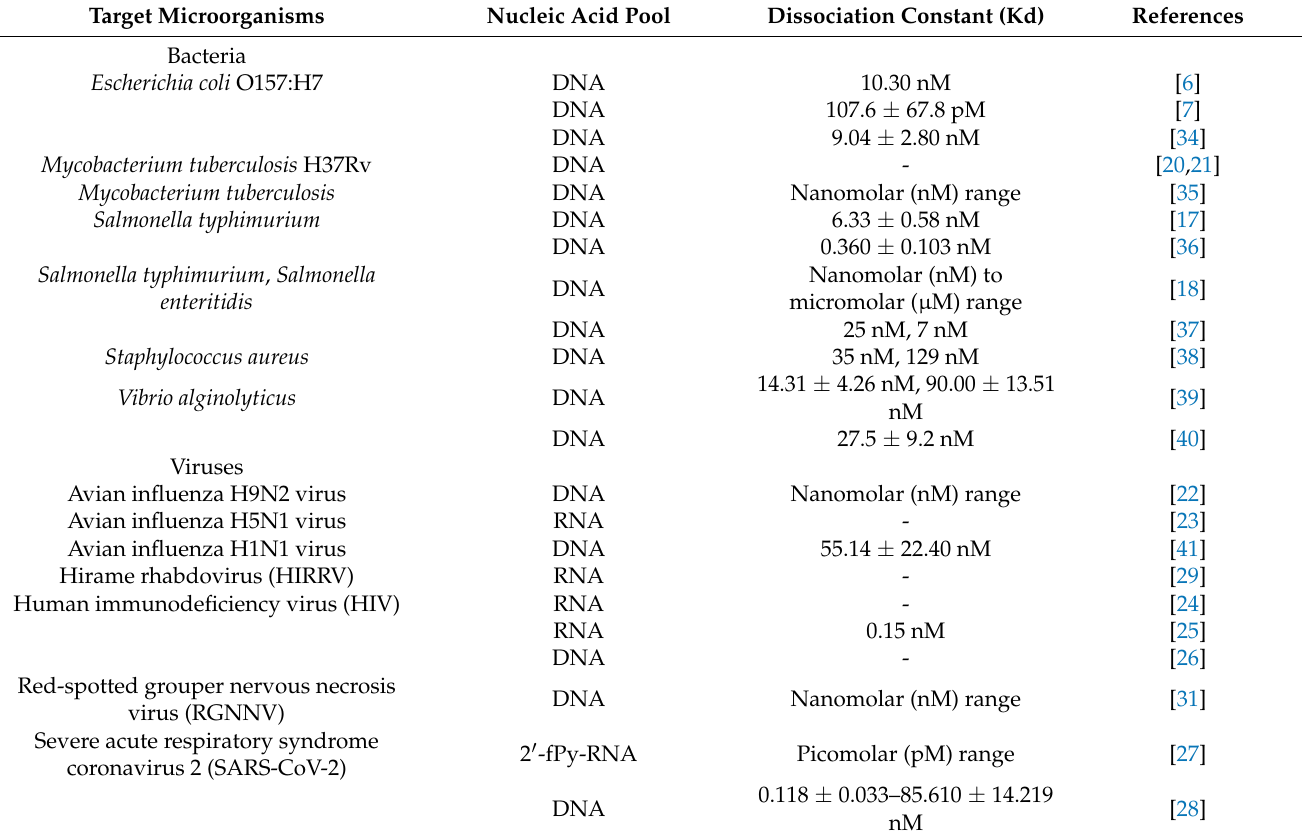
Table 1. Pathogenic bacteria, viruses and unicellular parasites targeted by